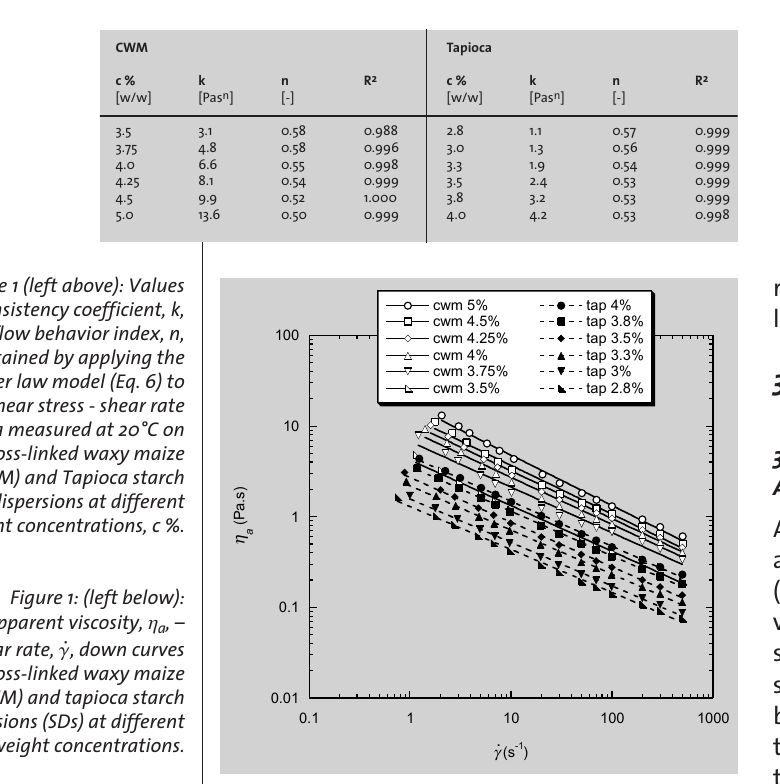
Table 1 (left above): Values of consistency coefficient, k, and flow behavior index, n, obtained by applying the power law model (Eq. 6) to the shear stress - shear rate data measured at 20°C on cross-linked waxy maize (CWM) and Tapioca starch dispersions at different weight concentrations, c %.